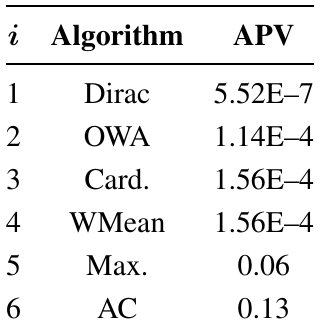
Table 4. Holm test to compare Card GA with respect to the different